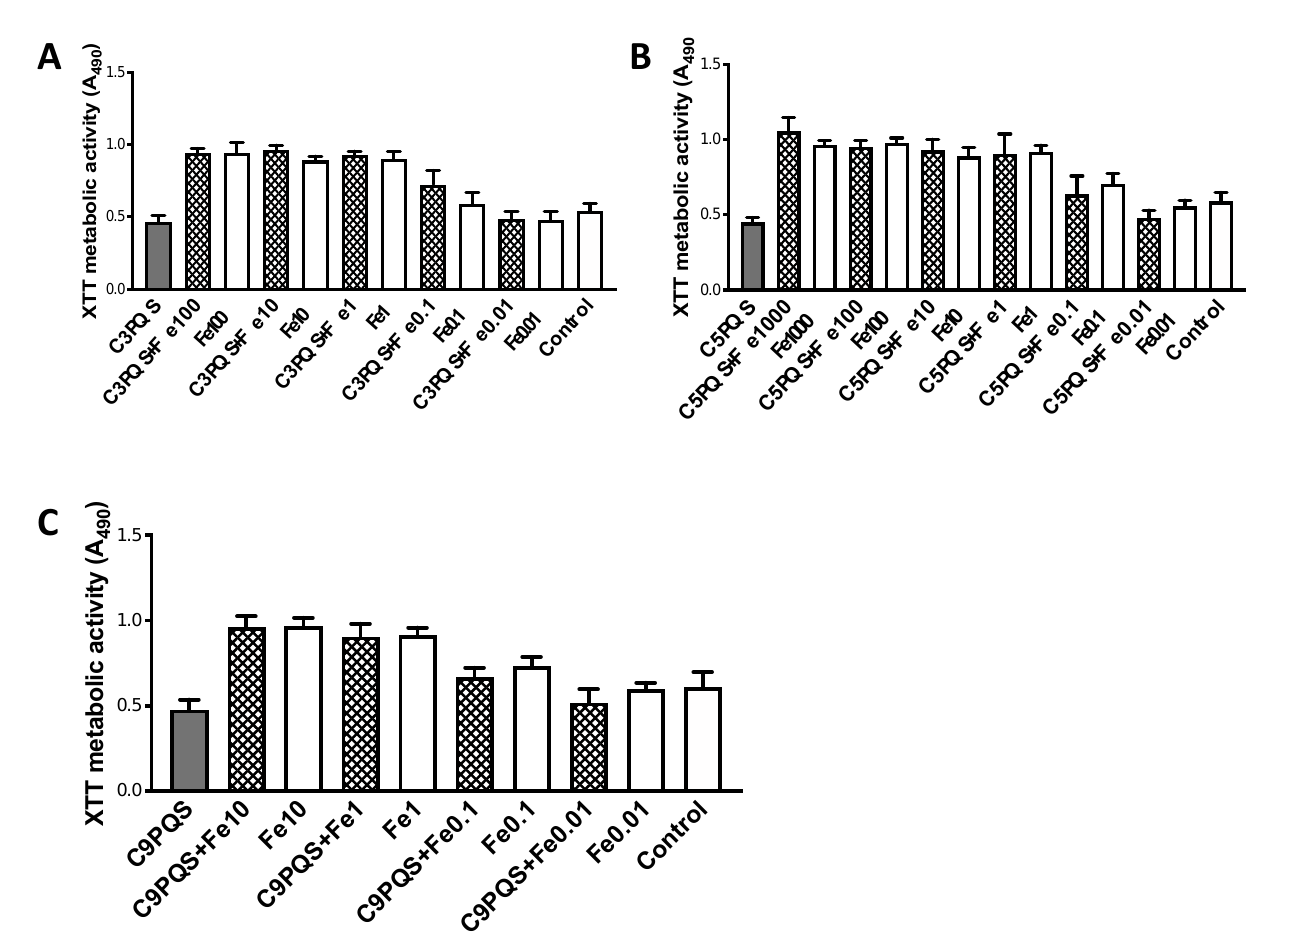
Figure 6. Studies of alkyl side chains on PQS. Fe reverses inhibition by side chain congeners, but combination of congeners with Fe does not boost metabolism above Fe alone. Target 10AF, all congeners studied at 12.5 μg/mL, DMSO controls are shown. Dilutions of Fe were made from 0.01 to 1000 μM final concentrations (these are the numbers on the x axis). In some experiments there were visible solubility problems with Fe 100–1000 μM, and the study values were the same as the next lower concentration; those bars are omitted. ( A ) C3-PQS (left bar) inhibits 10AF ( p < 0.01) compared to control (right bar). Fe begins to reverse C3-PQS effect at 0.01 μM Fe, and with concentrations of Fe 100 μM with C3-PQS, are all at p < 0.001 compared to C3-PQS alone. No significant boosting across these concentrations above Fe alone, for C3-PQS + Fe. ( B ) C5-PQS (left bar) inhibits 10AF ( p < 0.001) compared to controls (right bar). Fe evidently begins to reverse C5-PQS effect at 0.1 μM Fe, and at concentrations of Fe 1 to 1000 μM with C5-PQS, loss of inhibition is significant ( p < 0.001) compared to C5-PQS alone. No significant boosting across these concentrations above Fe alone, for C5-PQS + Fe. ( C ) C9-PQS (left bar) inhibits 10AF ( p < 0.01) compared to controls (right bar). Fe reverses C9-PQS effect at 0.1 to 10 μM Fe, loss of inhibition is significant ( p < 0.001) compared to C9-PQS alone. No significant boosting across these concentrations above Fe alone, for C9-PQS + Fe.